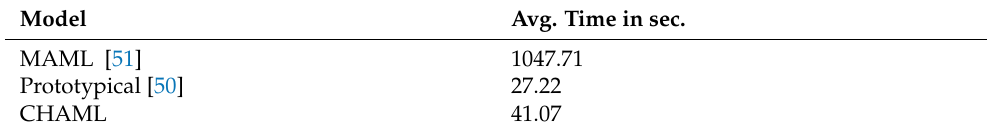
Table 6. CHAML vs. Meta-Learning Methods Average Computation